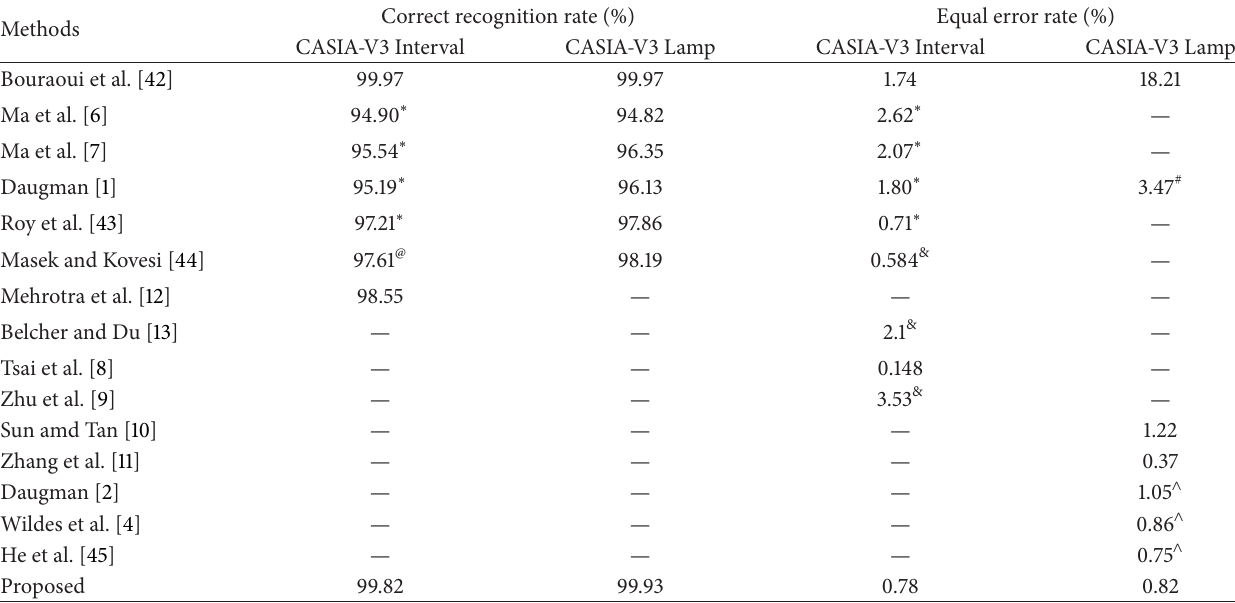
Figure 17: Classification accuracy of subfeature based on compounded selection by SVM classifier. Table 3: Comparisons of CRR and